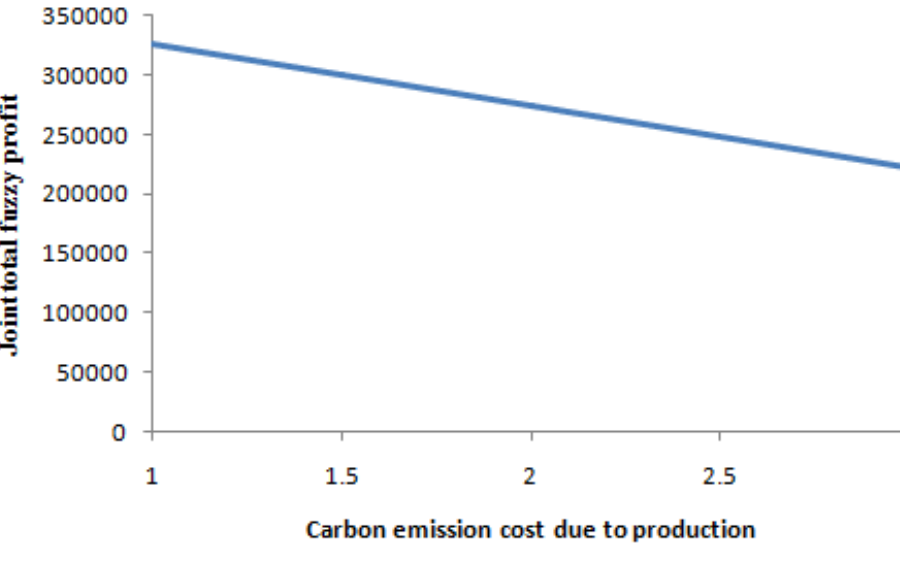
Figure 14. The carbon emission cost due to production vs total fuzzy profit